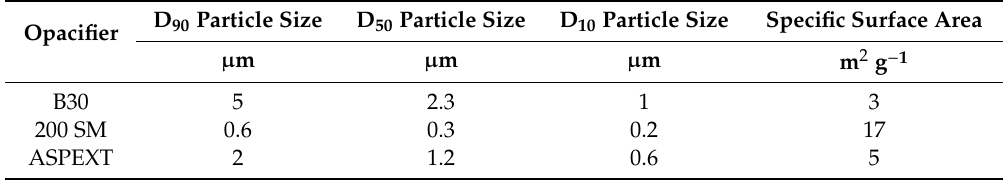
Table 1. Particle sizes and the specific surface areas of the di ff erent boehmite-based ceramic particles [31].